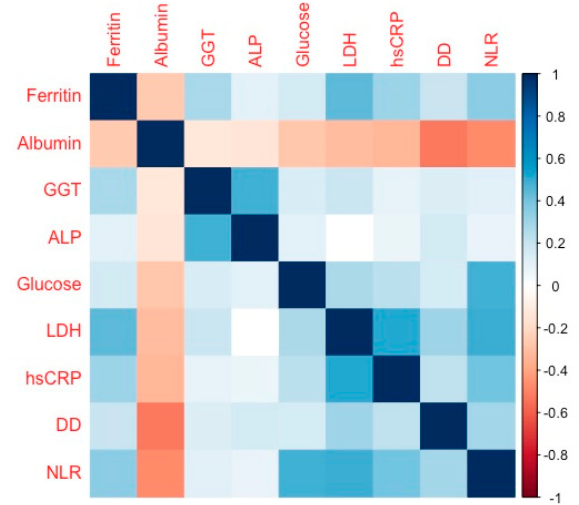
Figure 3. Correlogram illustrating the Spearman correlation coefficients between liver function parameters and inflammatory markers. Color intensity is proportional to the correlation coefficients.